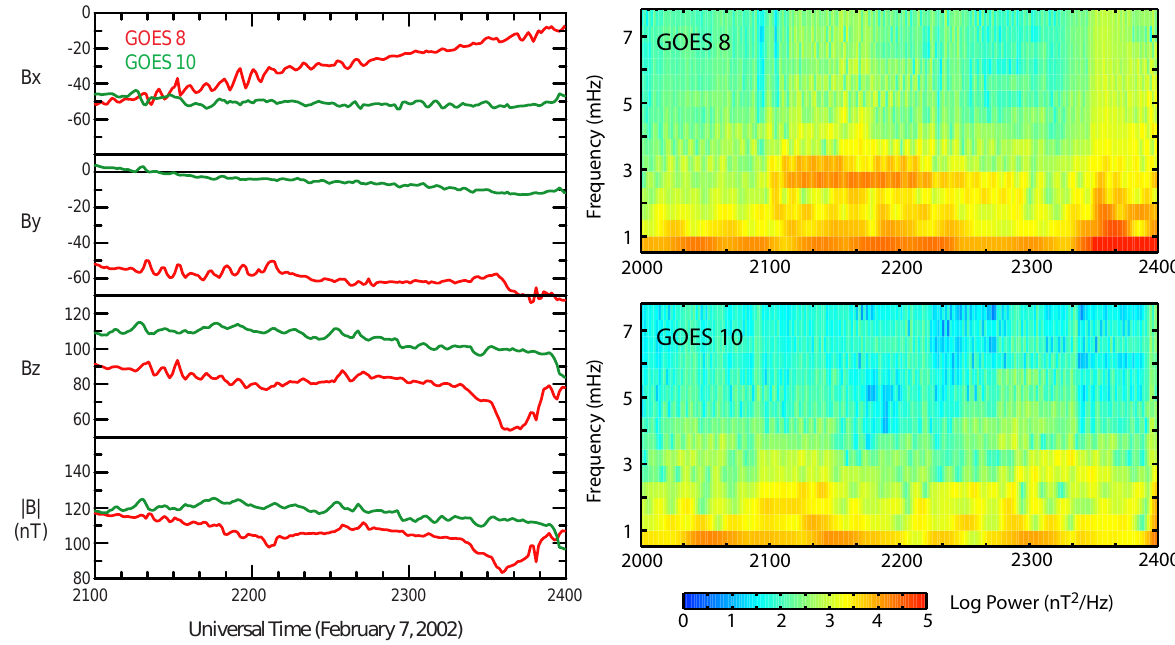
Fig. 7. The GOES 8 and 10 magnetic field data at 1-min time resolution (left panel) and their dynamic power spectra (right panels). The color bar shows the total power of the three components of the magnetic field in logarithm